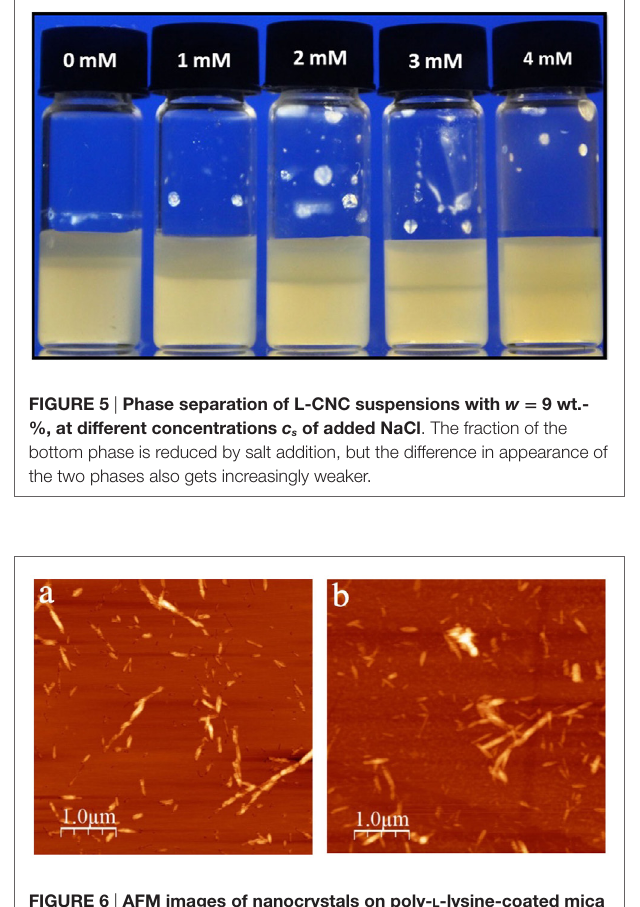
FigUre 6 | aFM images of nanocrystals on poly- l -lysine-coated mica substrates, for l-cnc in (a) and for h-cnc in (B), after addition of nacl to the suspension . The samples were prepared from w = 4 wt.-% CNC suspensions to which c s = 4 mM NaCl had been added diluted to w ′ = 0.002 wt.-% prior to dispensing on the substrate.